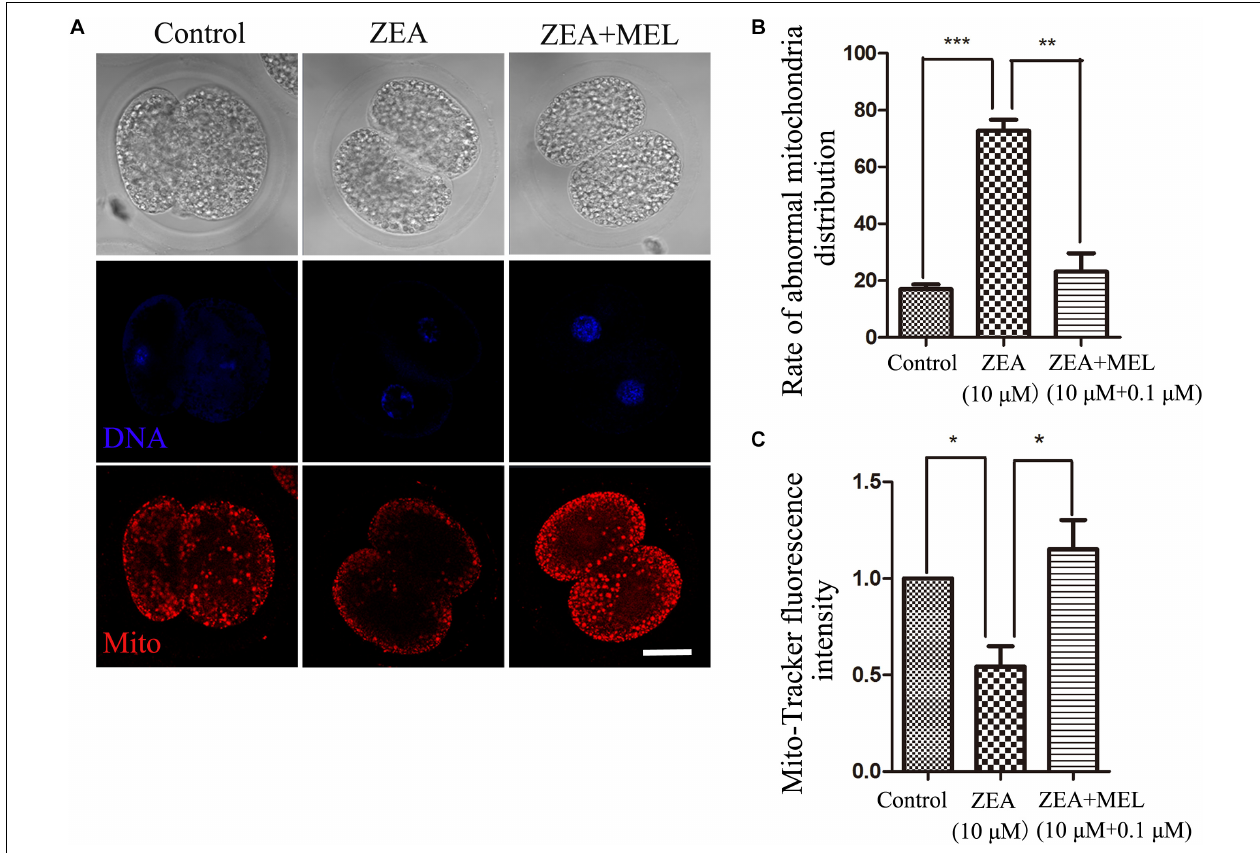
FIGURE 2 | The effect of ZEA and co-exposure of ZEA and melatonin on mitochondria of embryo. (A) Representative images of Mito-Tracker (red) fluorescence in the embryos of the control, ZEA-exposed, ZEA+MEL groups. Bar = 20 µ m. (B) Abnormal rate of mitochondria distribution in the control, ZEA-exposed, ZEA+MEL groups. ∗∗ P < 0.01 and ∗∗∗ P < 0.001. (C) Mito-Tracker fluorescence intensity in control, ZEA-exposed, ZEA+MEL groups, and Fluorescence images were measured by confocal microscope with the same settings and parameters. ∗ P < 0.05.